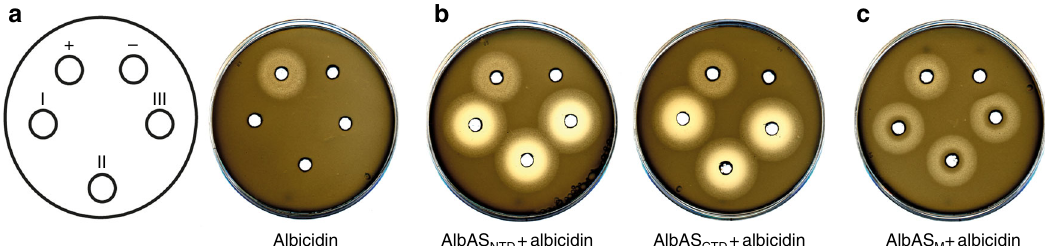
Fig. 2 Agar diffusion assays. a – c AlbAS, AlbAS NTD , AlbAS CTD , and AlbAS M (40 µ M) with 40 μ M albicidin (in triplicates I – III). The fi rst plate illustrates the sample arrangement on the assay plates. Positive control with only 40 µ M albicidin ( + ) and negative control with 40 µ M protein in 5% DMSO and buffer ( − ) are shown on top. Representative results are shown for three independent